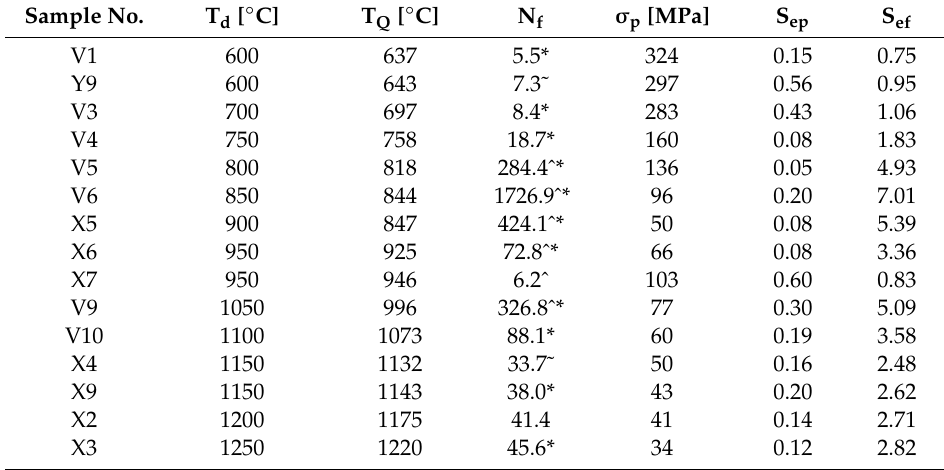
Table 4. Results of hot torsion testing according to the basic programme (BP). Sample